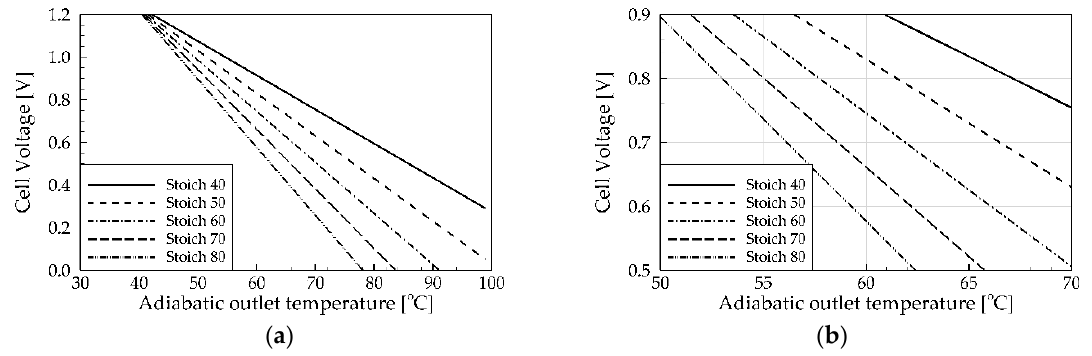
Figure 7. Dependency of the adiabatic outlet temperatures of the product stream on the operating cell voltage. The incoming conditions were a temperature of 40 ° C and a relative humidity of 30 %. ( a ) Entire voltage range, ( b ) close-up on the region of interest.